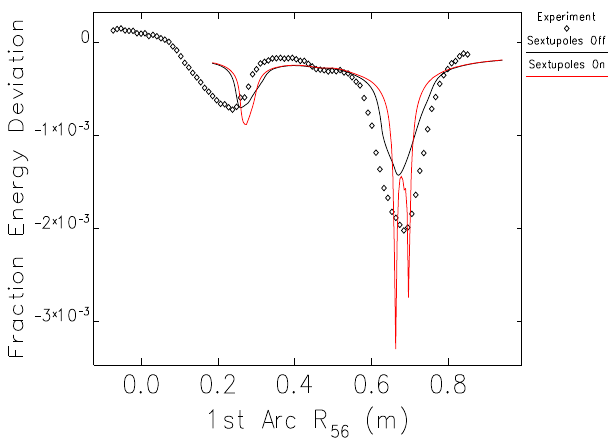
FIG. 2. Energy loss measurement and simulation due to CSR as a function of R A 1 56 for falling rf